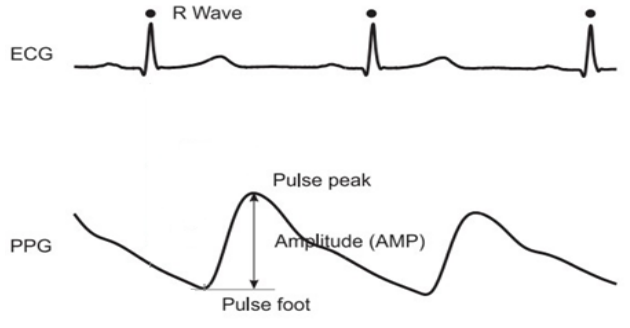
Figure 3. Waveform of PPG and ECG signals in which ECG is the manifestation of heart contractile activity while PPG is signals that measure the changes in skin blood volume and perfusion. These signals are further extracted into useful parameters as inputs to inference network for vigilance